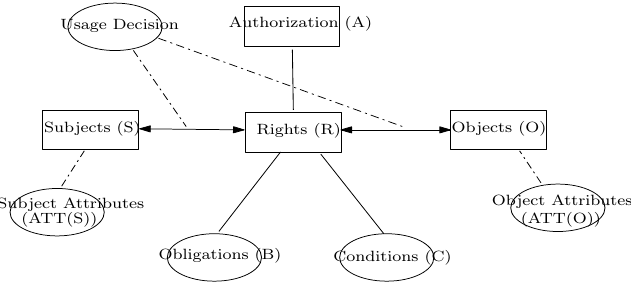
Figure 1. Components of UCON